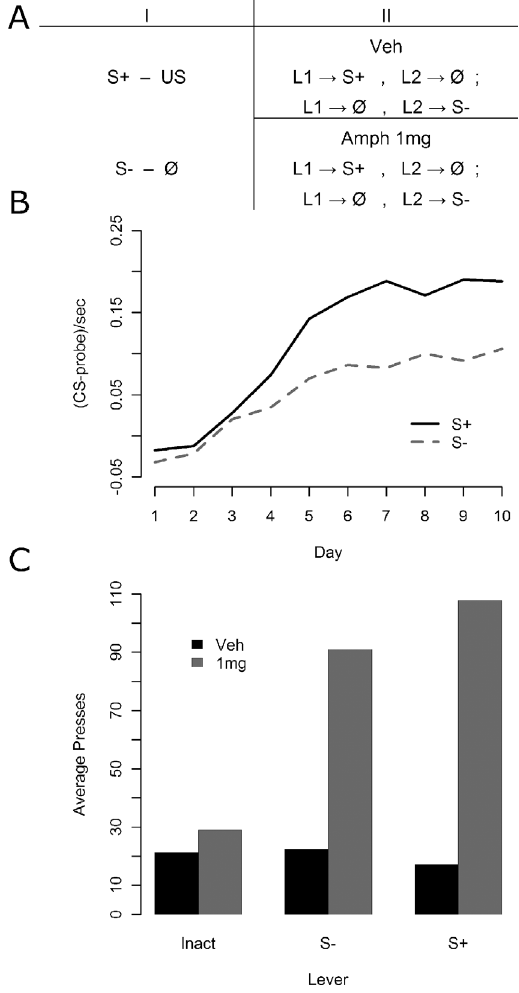
Figure 3. The effect of amphetamine on sensory and secondary reward in Experiment 3. ( A ) Experiment 3 again first included Pavlovian discrimination training. Instrumental conditioning then proceeded, this time in two groups: one that received vehicle injections before every session, and one